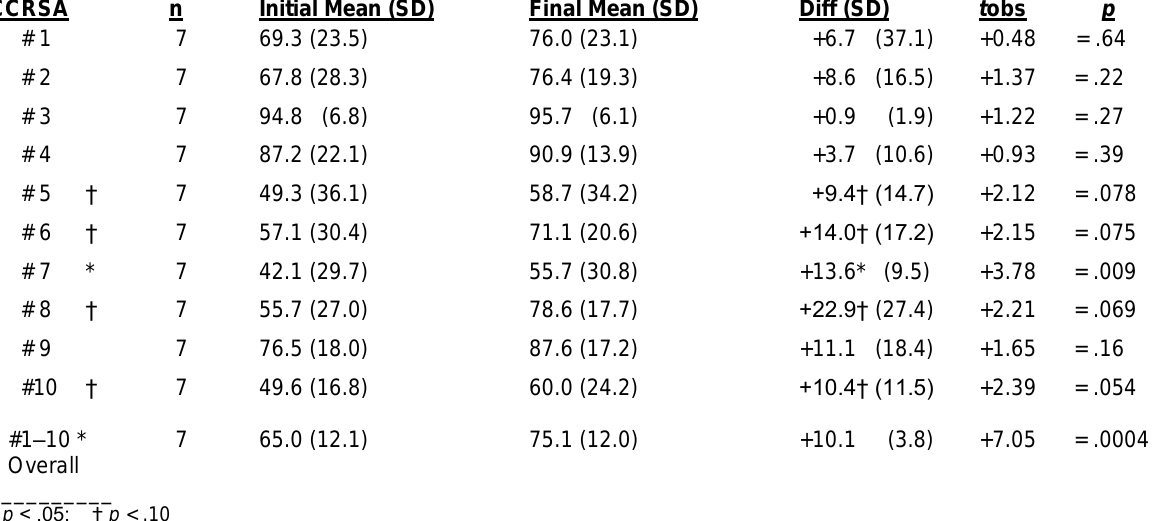
Table 6. RIC - CCRSA (Communicative Confidence) Changes in SCALE Participants with Chronic Aphasia Following Remote Therapy and On-line Exercise